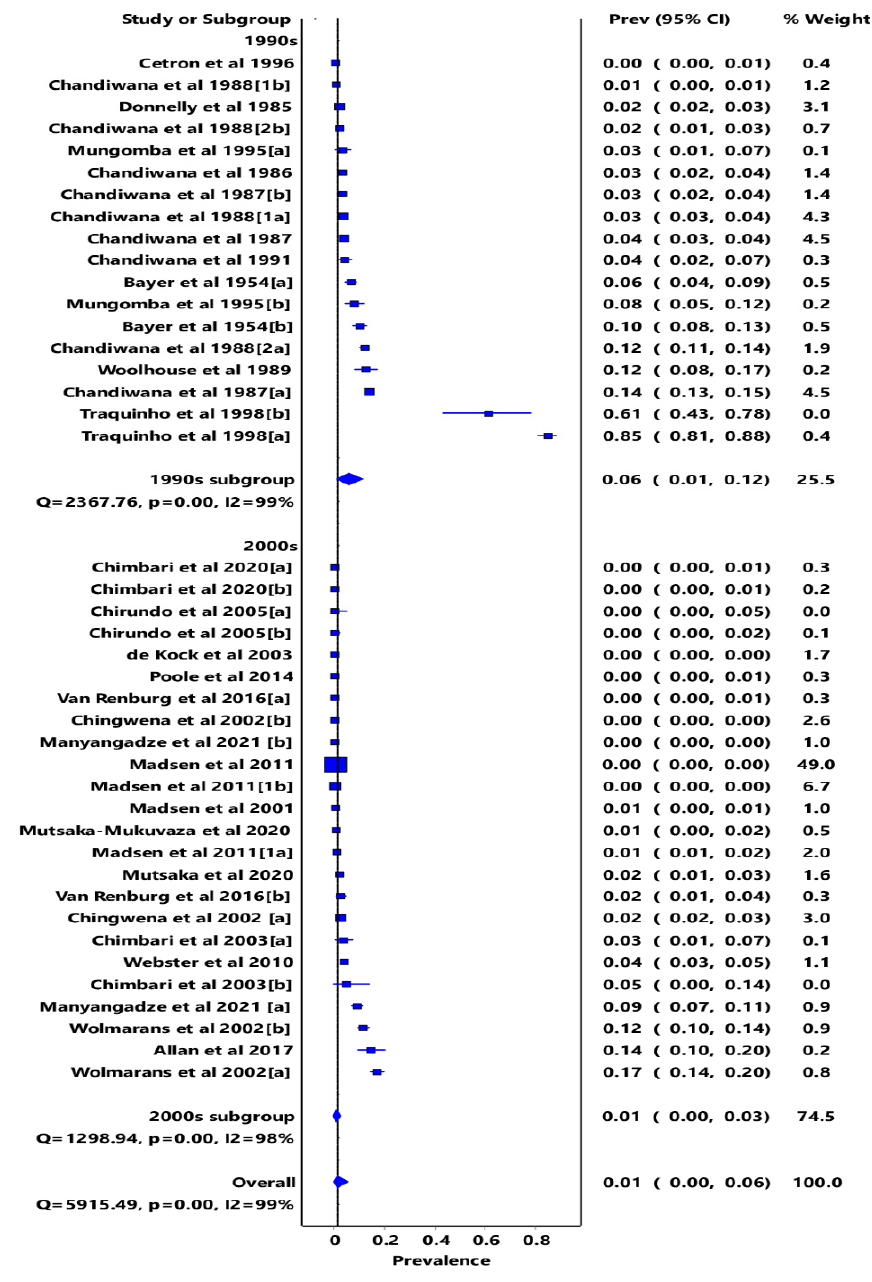
Figure 2. Forest plot of subgrouped PPE analysis of infectivity in the 1900s and 2000s [18–45]. [a] and [b] represents Bulinus spp. and Biomphalaria spp. respectively when both species are of interest to the author(s). [1a] and [1b] represents Bulinus spp. and Biomphalaria spp. respectively when both species are of interest to the author(s) and is the first of two articles published in the same year by the same authors. [2a] and [2b] represents Bulinus spp. and Biomphalaria spp. respectively when both species are of interest to the author(s) and is the second article published in the same